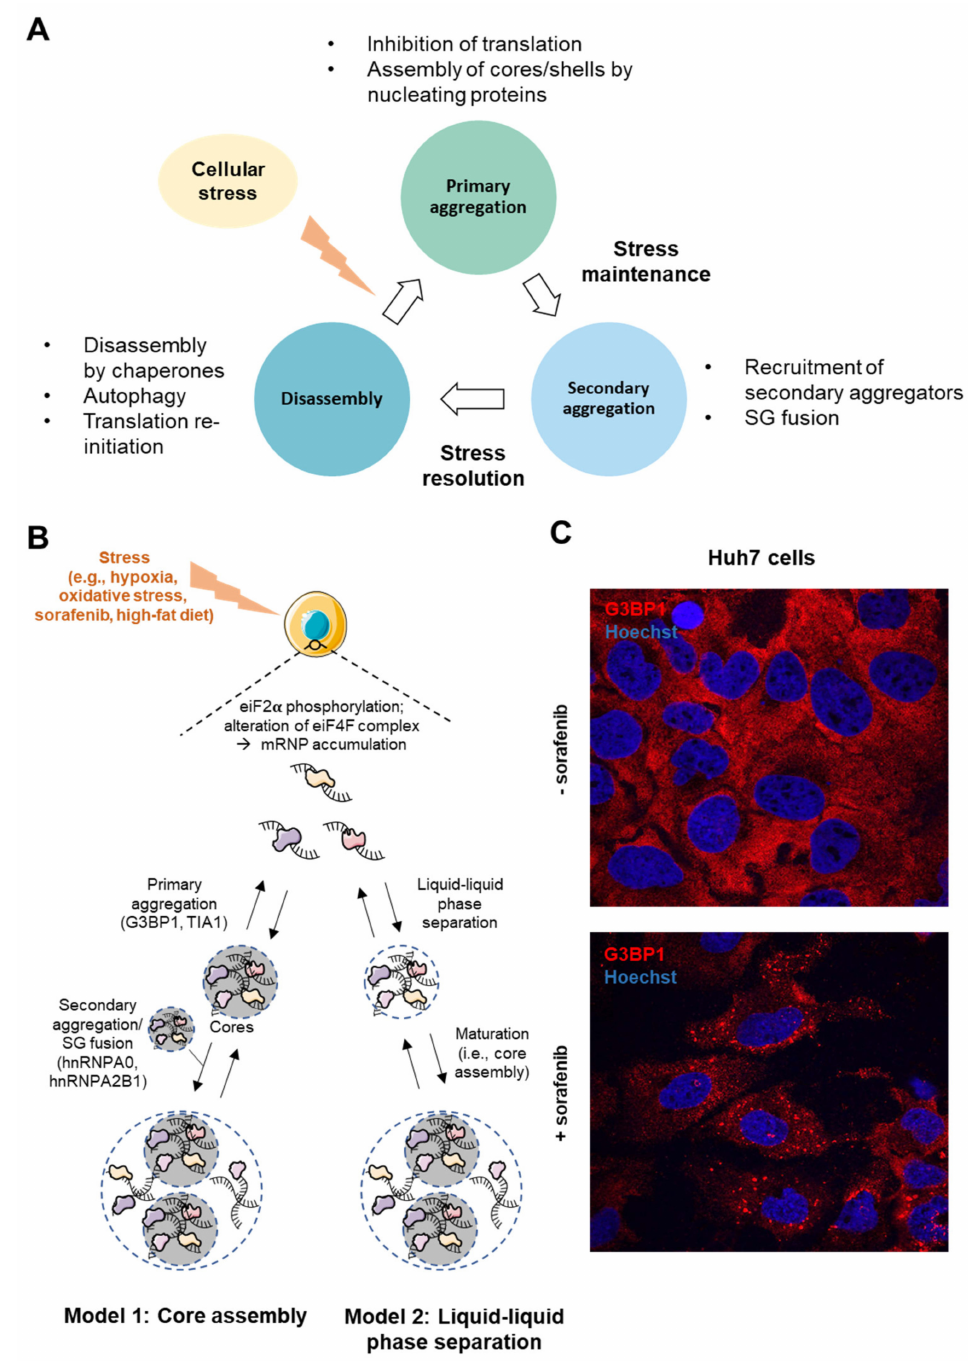
Figure 2. Stress Granule assembly. ( A ) The cycle of stress granule formation and disassembly. ( B ) SGs in the liver can form during stressful events such as hypoxia, oxidative stress, sorafenib treatment or high-fat diet. Two models of SG assembly have been described. In the “core first” model, nucleating proteins (e.g., G3BP1 and TIA1) form a stable core, and later, other SG-associated proteins are recruited to form the dynamic shell. Alternatively, in the ‘LLPS first’ model, proteins bound to transcripts assemble through interactions of their IDD domains. Further on, highly dense fractions form SG cores. ( C ) Confocal microscopy images of SG formation (G3BP1 staining in red; Hoechst-33342 staining in blue) in hepatic Huh7 cancer cells after 24 h treatment with 5 µ M sorafenib (63 ×